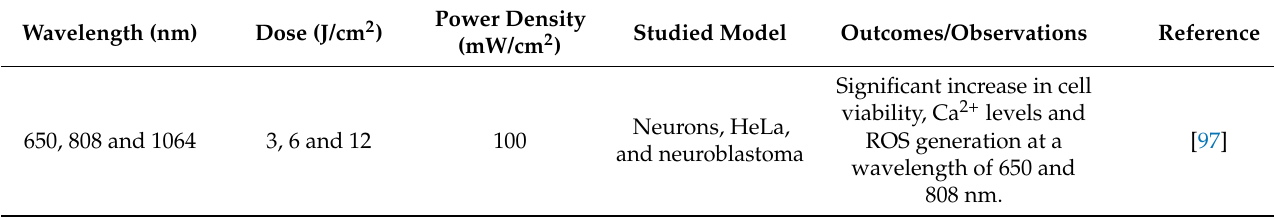
Table 2. The effects of PBM on cellular